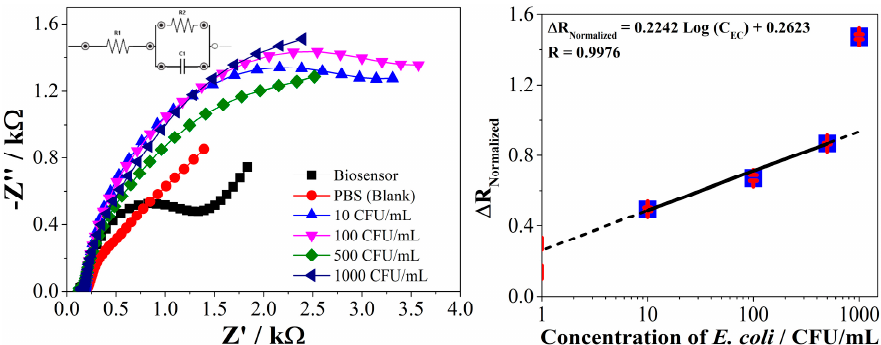
Figure 9. Results of electrochemical detection of E. coli (0 to 1000 CFU/mL) by using the screen-printed electrodes modified with AuNPs and PEPTIR-1.0 as recognition molecule. ( Left ): Nyquist diagram of the detection of 0 (blank, PBS), 10, 100, 500 and 1000 CFU/mL of E. coli (insert: Randles circuit used for fitting data). ( Right ): Correlation of normalized charge transfer resistance values ( Δ R Normalized ) with the concentrations of E. coli . 2.0 mM of [Fe(CN) 6 ] − 3/ − 4 in 0.1 M of KCl aqueous solution.